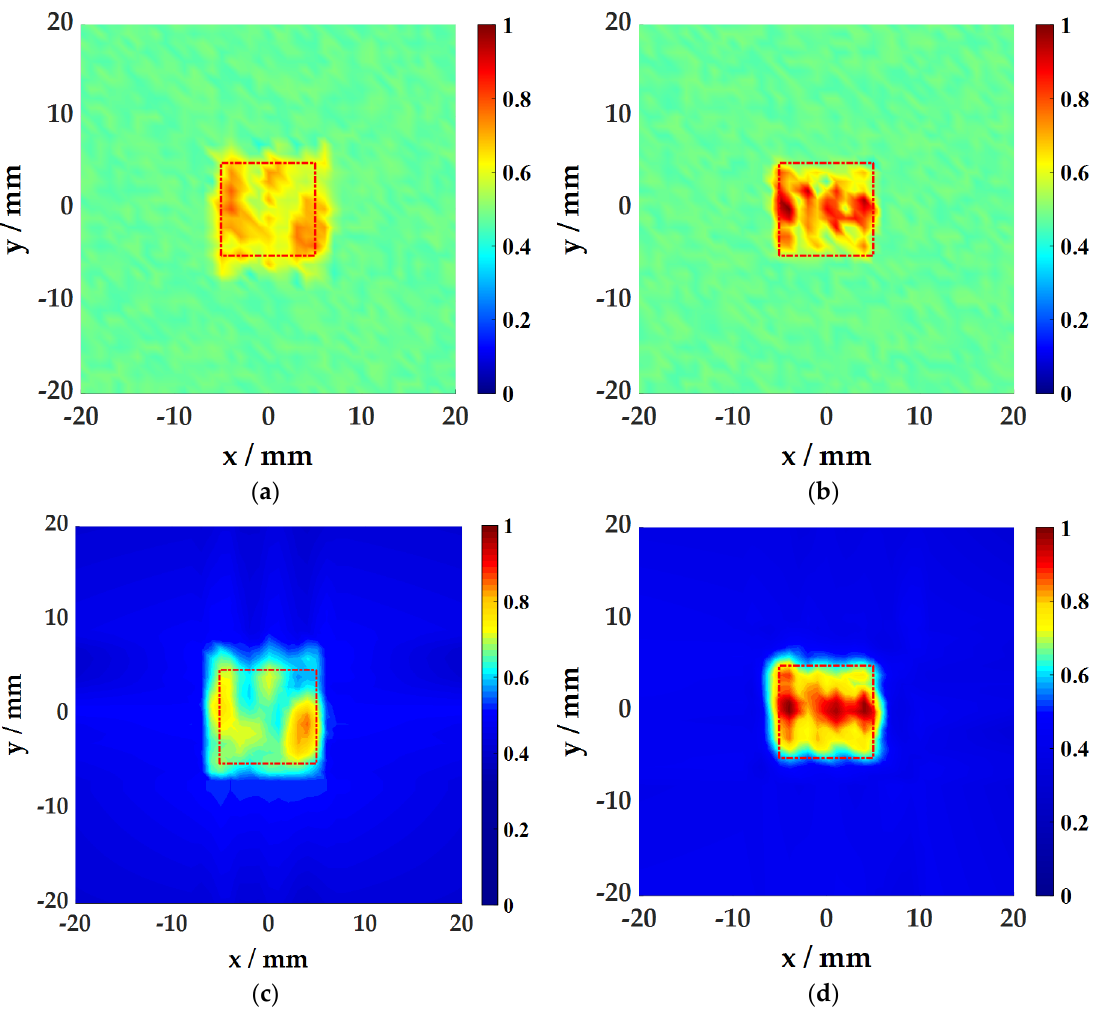
Figure 12. Damage Imaging results of the aluminum plate: ( a ) Imaging of damage at 1 mm depth using the WFA; ( b ) Imaging of damage at 1.5 mm depth using the WFA; ( c ) Imaging of damage at 1 mm depth using the SWA; ( d ) Imaging of damage at 1.5 mm depth using the SWA.